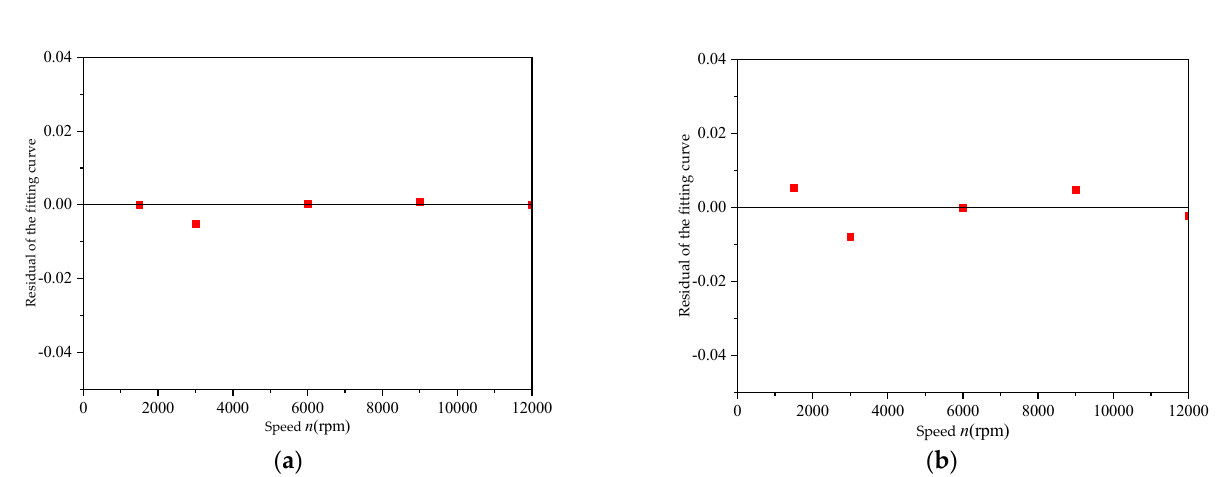
Figure 9. The variation law of the reduction coefficient with rotational speed: ( a ) exponential function fitting and ( b ) power function fitting.